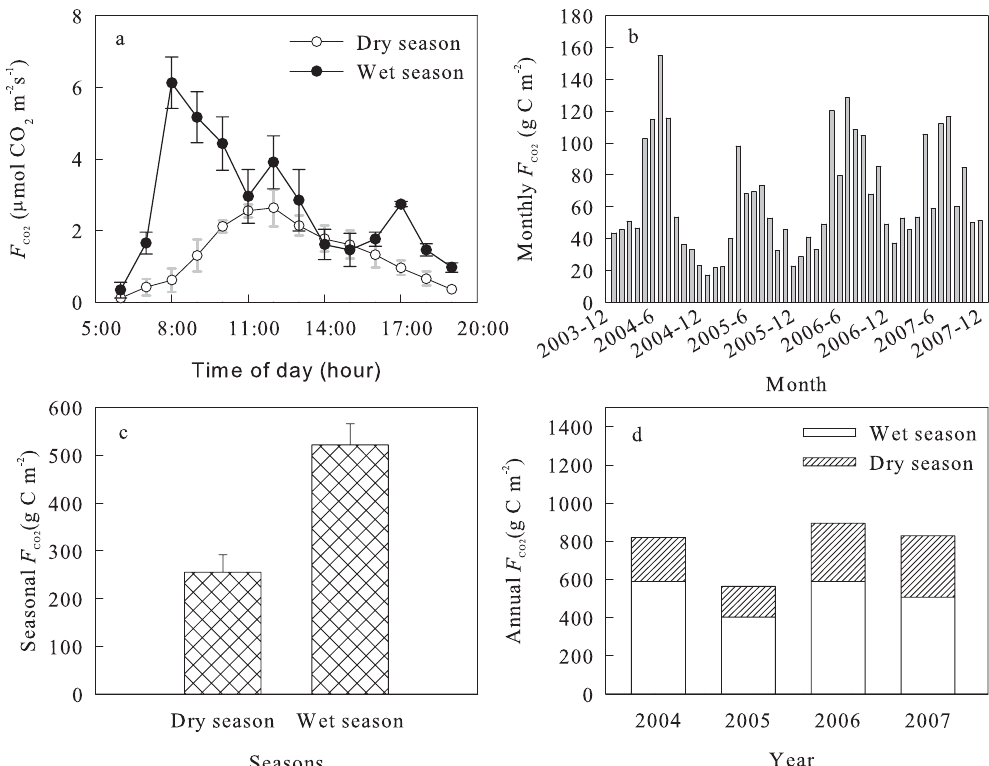
Fig. 5. Diurnal, monthly, seasonal, and annual trends of canopy CO 2 uptake rate ( F CO bars indicate standard error. Data were obtained by the SF/SI